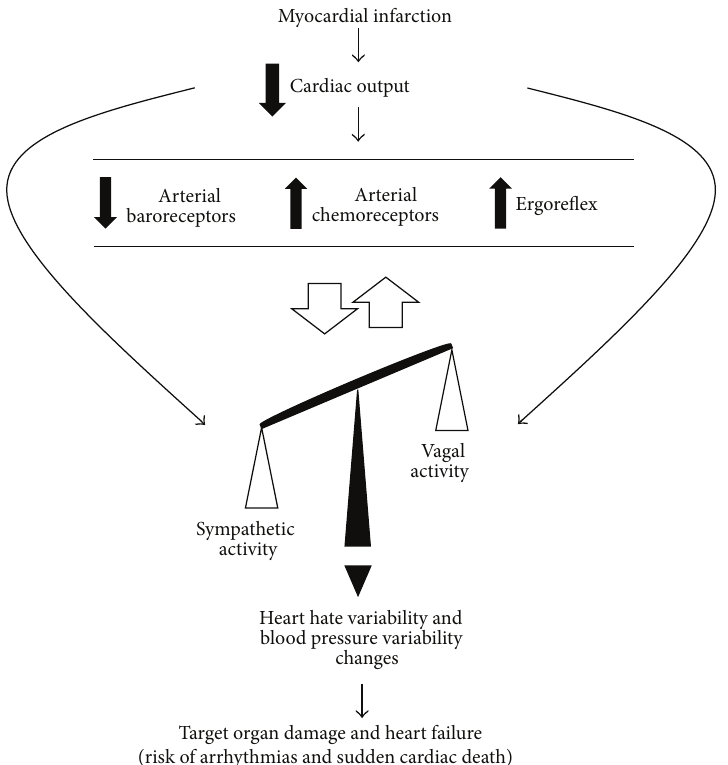
Figure 1: Cardiovascular reflexes impairment and cardiac autonomic nervous system imbalance after myocardial